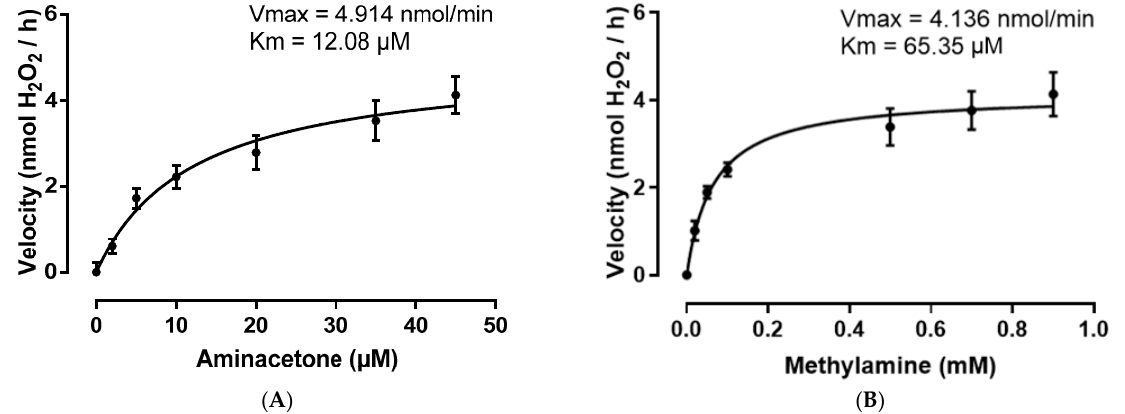
Figure 3. SSAO kinetic parameters (Vmax and Km) in the presence of aminoacetone ( A ) and methy- lamine ( B ) as substrates. The data was analyzed with the non-linear regression model of Michaelis- Menten Y = Vmax ∗ X/(Km + X). Values are mean ± S.E.M. (n =